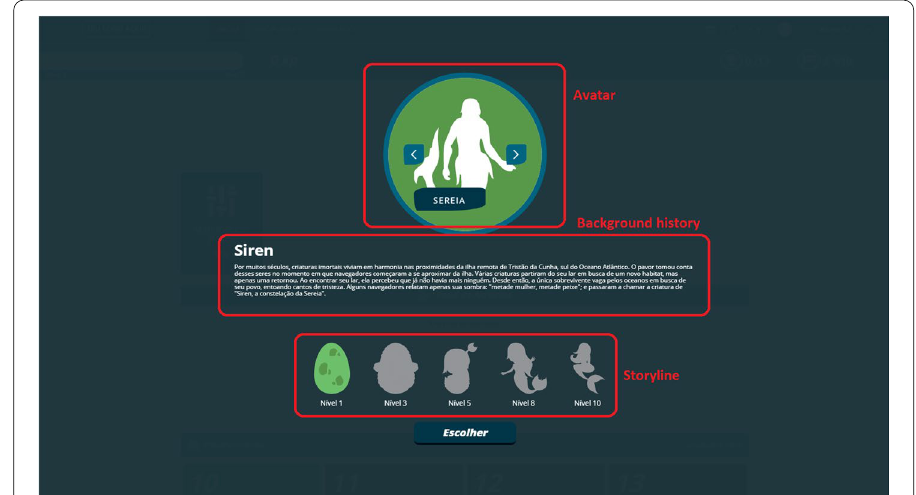
Fig. 2 MeuTutor default version (Avatar selection)